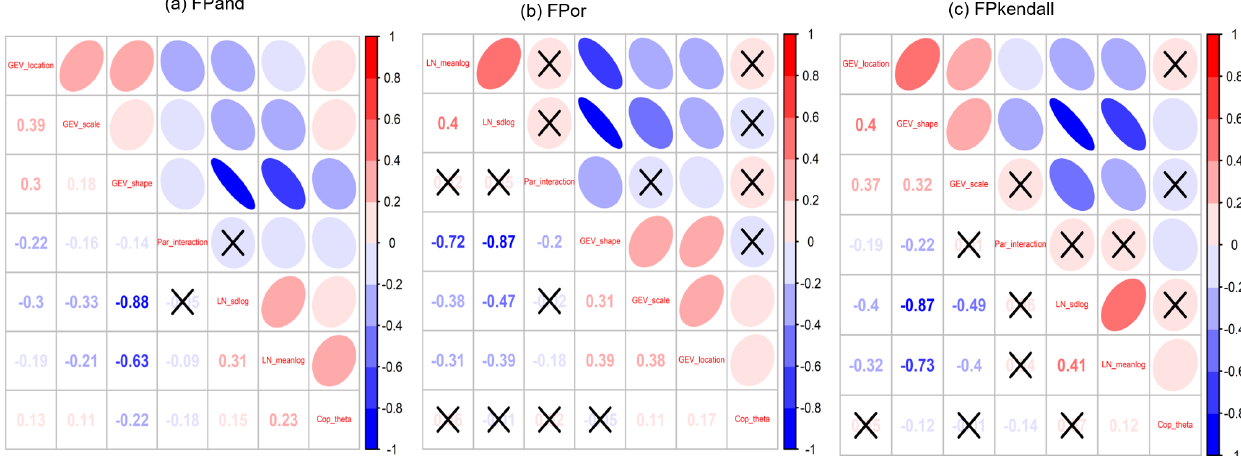
Figure 11. Correlation for parameters’ contributions to risk inferences at the Zhangjiashan station for a design standard of 200 years and a service time of 30 years: the cross sign indicates the correlation is statistically insignificant.